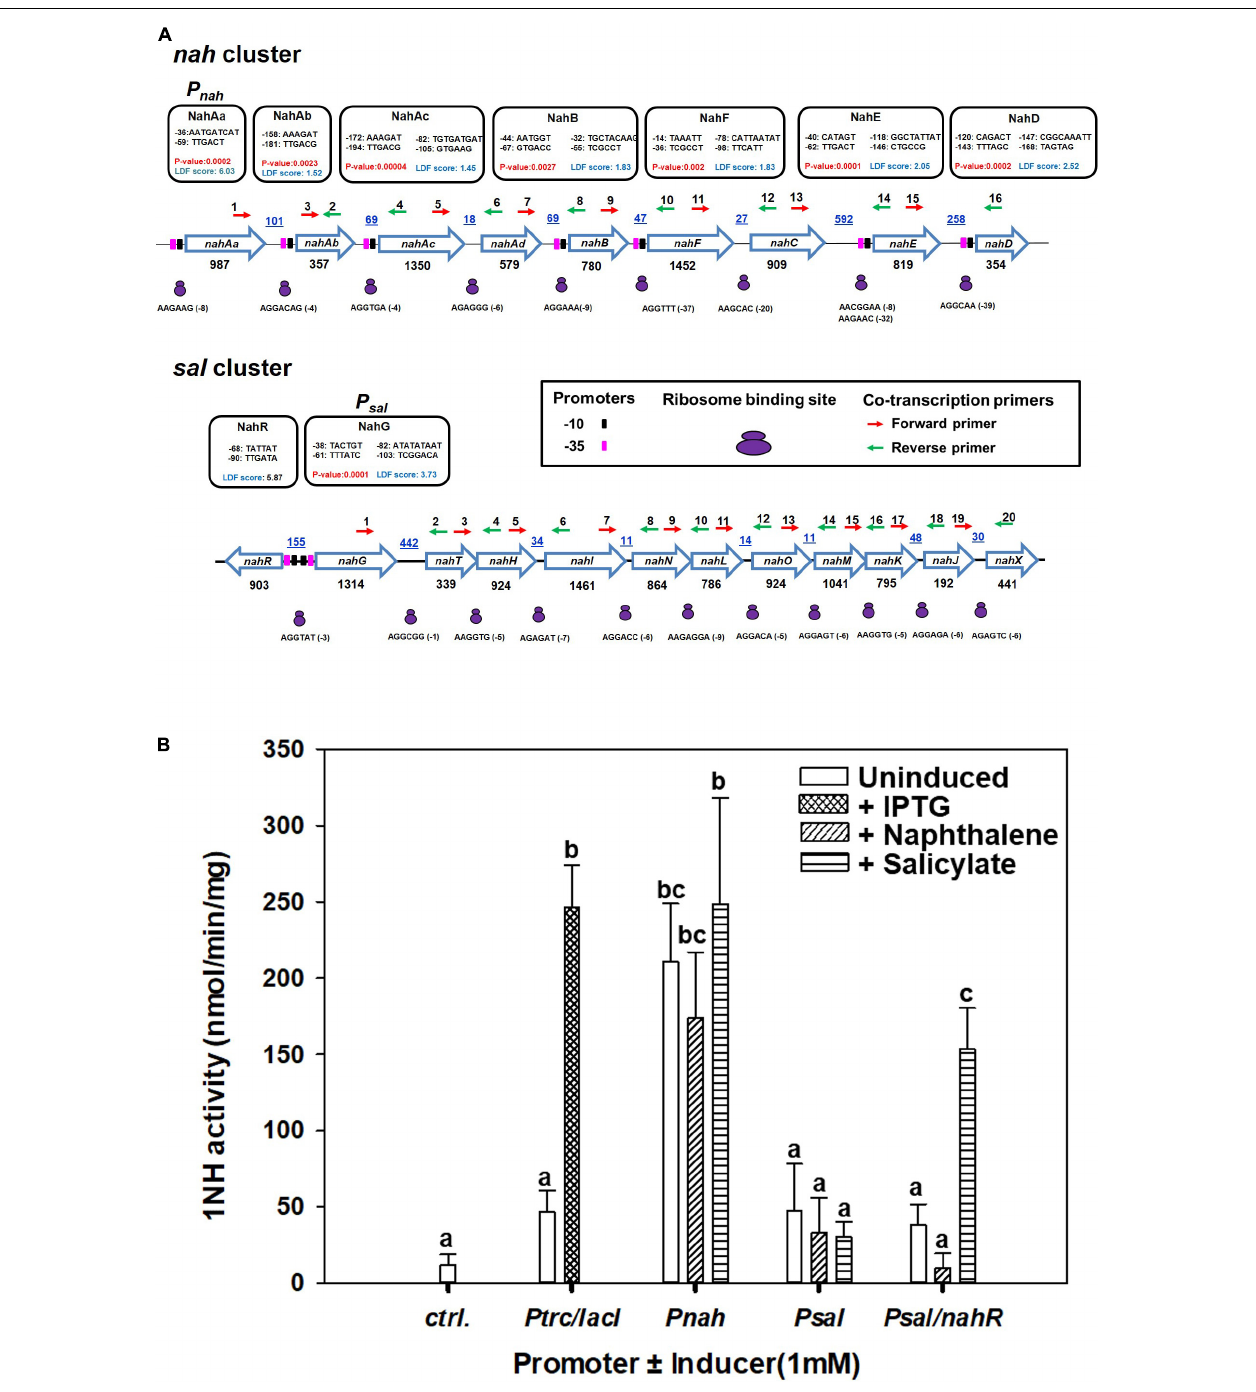
FIGURE 6 | Analysis of the upstream regions of nah and sal operons present on ICE nah CSV86 of Pseudomonas bharatica CSV86 T . (A) Operonic arrangement of upper ( nah ) and lower pathway (sal) genes and identification of putative promoter sequences [-10 (black filled rectangles) and -35 (pink filled rectangles) boxes], ribosome binding sites (RBS, as small and large purple ovals), and the location of primers [forward (red) and reverse (green) arrows] used for co-transcription analysis. The putative promoter sequences are depicted in the black box. The promoters with LDF scores have been predicted using BPROM and P -values were predicted using SAPPHIRE. The intergenic distances (bp) are indicated by blue color with underline, while gene lengths (in bp) are denoted below each gene. (B) Specific activity of 1-naphthol 2-hydroxylase (1NH) from various constructs expressed in E. coli BL21 (DE3) using different promoters and inducers. The bar represents the mean value with standard deviation ( n = 3). Statistically significant differences ( P = 0.05) among different promoter systems are denoted by a, b, c (Tukey’s post hoc test).